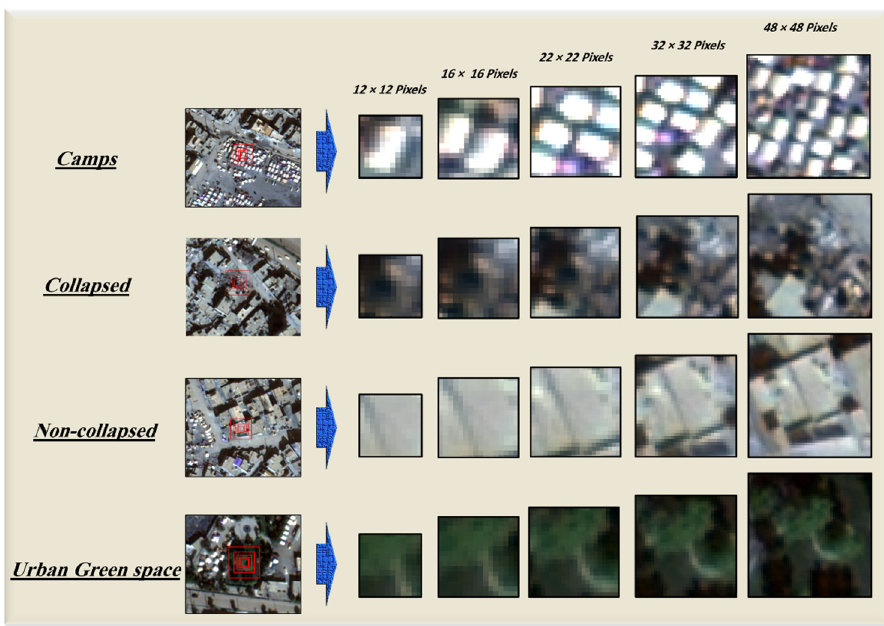
Figure 4. Examples of scale differences in urban objects. The figure also shows the image context when applying the segmentation task in OBIA which should detect the objects and develop them as image objects.